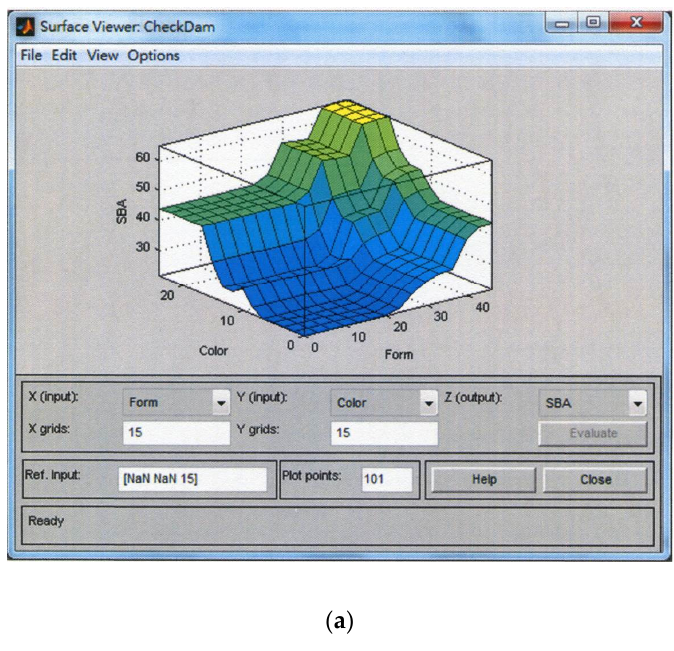
Figure 5. Cont. Figure 5.